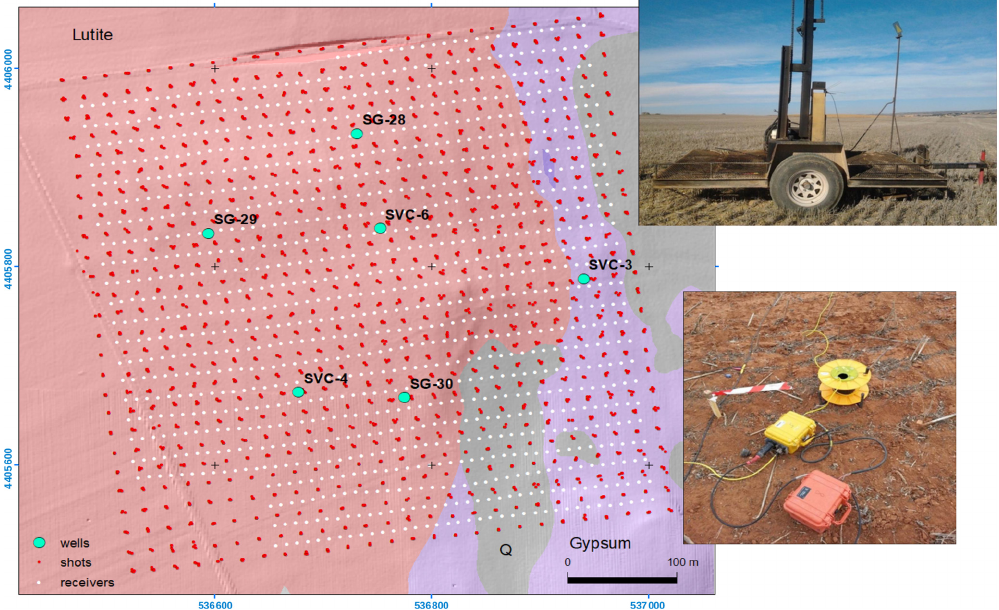
Figure 2. Geometry of the acquisition experiment. Red dots mark the positions of the sources, white dots mark the positions of the receivers. Receivers consisted of single vertical-component exploration geophones connected to an array of 10 GEODE (Geometrics) data acquisition systems. Light blue dots indicate drilled boreholes. A 250kg weight drop was used (from the Inst. Superior Tecnico Lisbon,